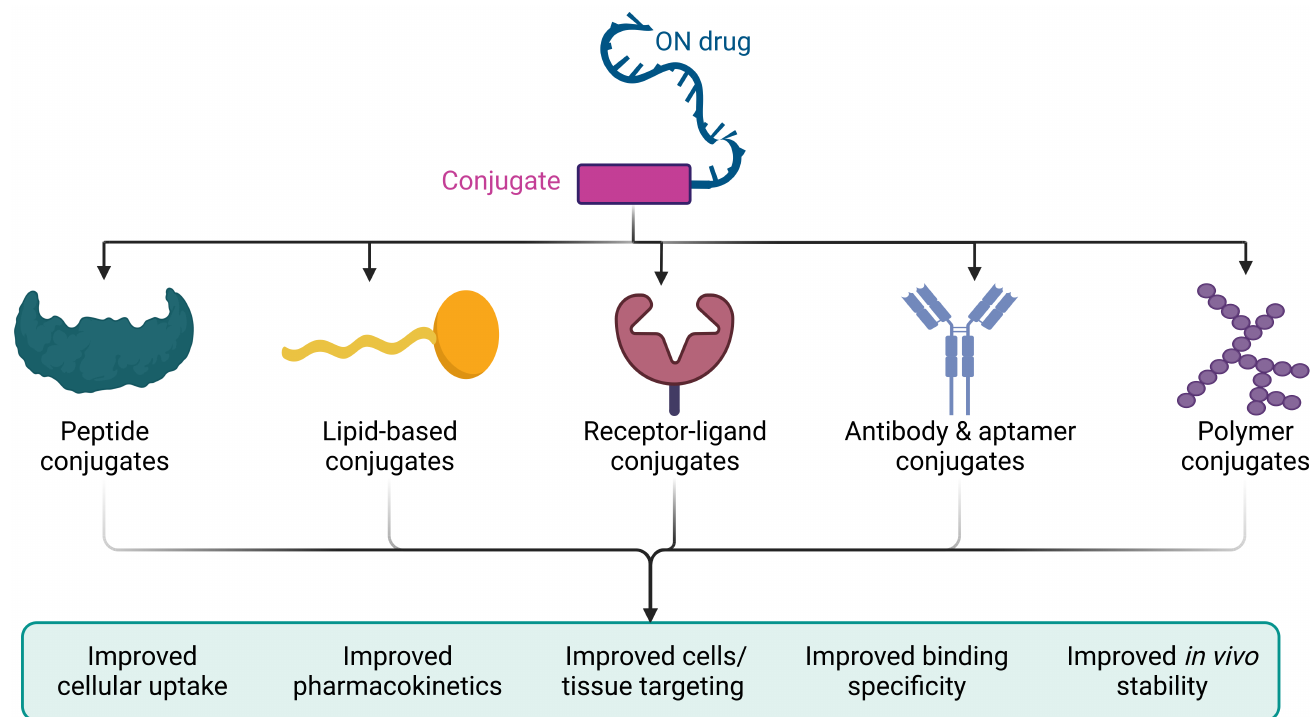
Figure 6. This is a wide figure. Figure 5. ON bioconjugation. Bioconjugation improves the cellular uptake, pharmacokinetics, targeting, and binding specificity of ON, leading to improved stability, efficacy, and safety (Created with BioRender: Table 2. This is a wide table.